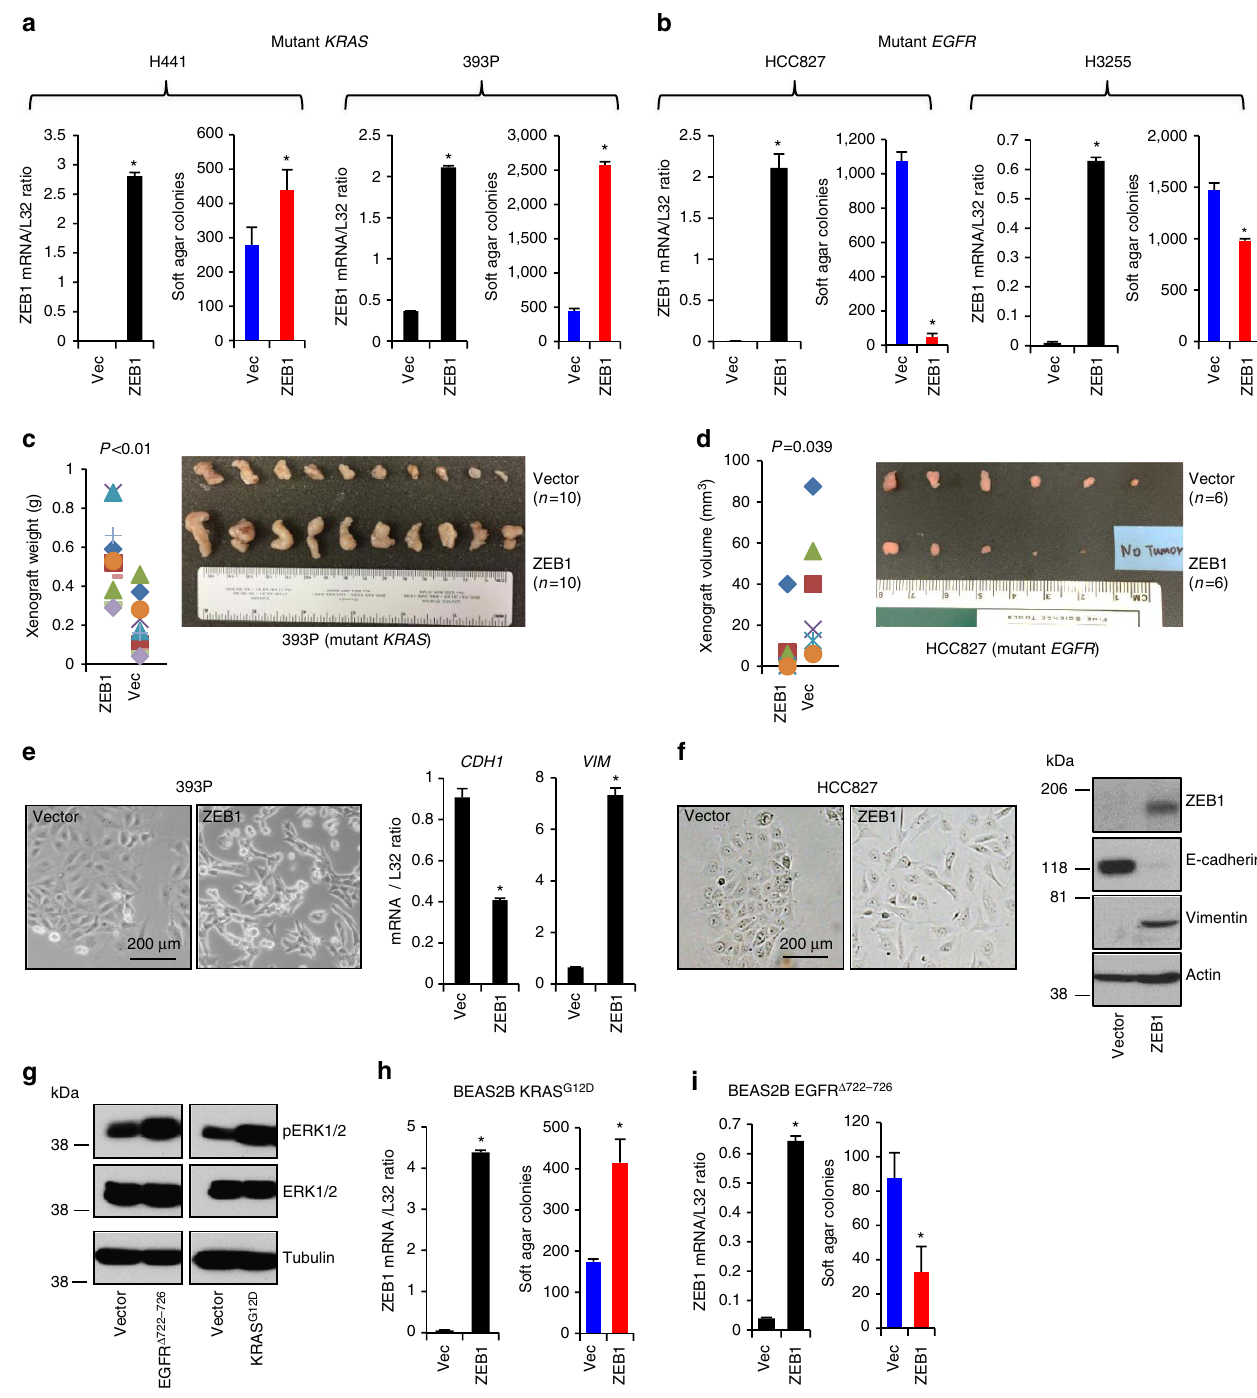
Figure 2 | ZEB1 distinctly regulates soft agar and xenograft tumour growth of lung cancer cells expressing mutant KRAS or mutant EGFR . ZEB1 distinctly regulates soft agar growth of lung cancer cells expressing mutant KRAS ( a , H441 and 393P cells) or mutant EGFR ( b , HCC827 and H3255 cells). ZEB1 expression was quantified by qPCR (left bar charts in a and b ) and numbers of soft agar colonies formed by 1 (cid:3) 10 4 cells in six-well plates (triplicates; mean plus s.d.) in 3 weeks were counted (coloured bar charts in a and b ). * indicates t -test P o 0.05. ZEB1 promotes KRAS-mutated 393P xenograft tumour growth ( c ) but inhibits EGFR-mutated HCC827 xenograft tumour growth ( d ). Xenograft tumours were weighed and measured (scatter plots in c and d ) and photographed (pictures in c and d ). ZEB1 promotes EMTof both 393P and HCC827 cells. EMTwas examined by morphological changes (pictures on left; scale bar: 200 m m) and by qPCR for CDH1 and VIM ( e , bar charts; triplicates; mean plus s.d.) or western blotting for E-cadherin and Vimentin ( f , gels). ( g ) Western blotting for BEAS2B cells expressing KRAS G12D or EGFR D 722–726 , or a control empty pcDNA3.1 vector. ZEB1 distinctly regulates soft agar growth of BEAS2B cells expressing KRAS G12D ( h ) or EGFR D 722-726 ( i ). ZEB1 expression was quantified by qPCR (left bar charts in h and i ) and numbers of soft agar colonies formed by 1 (cid:3) 10 4 cells in six-well plates (triplicates; mean plus s.d.) in 3 weeks were counted (coloured bar charts in h and i ). * indicates t -test P o